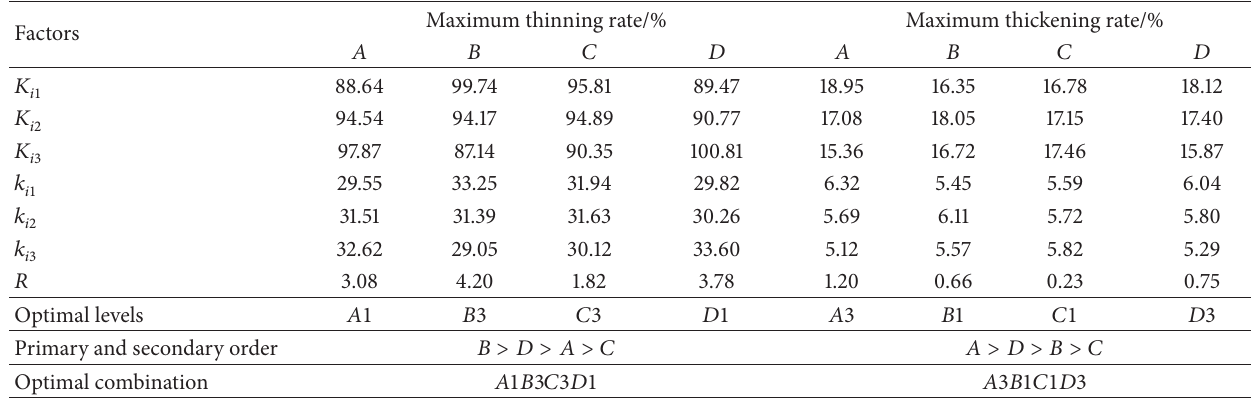
Table 5: Range analysis of thickness reduction and thinness reduction